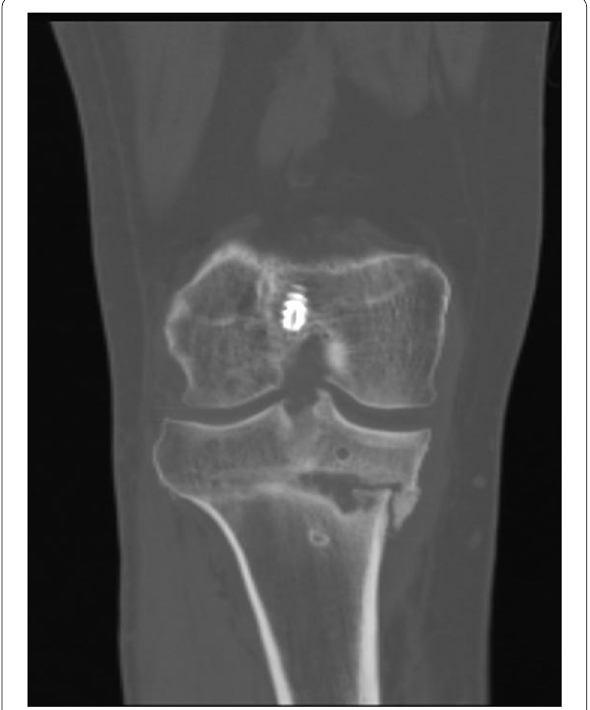
Fig. 10 A coronal CT slice demonstrating varus collapse of the osteotomy with nonunion